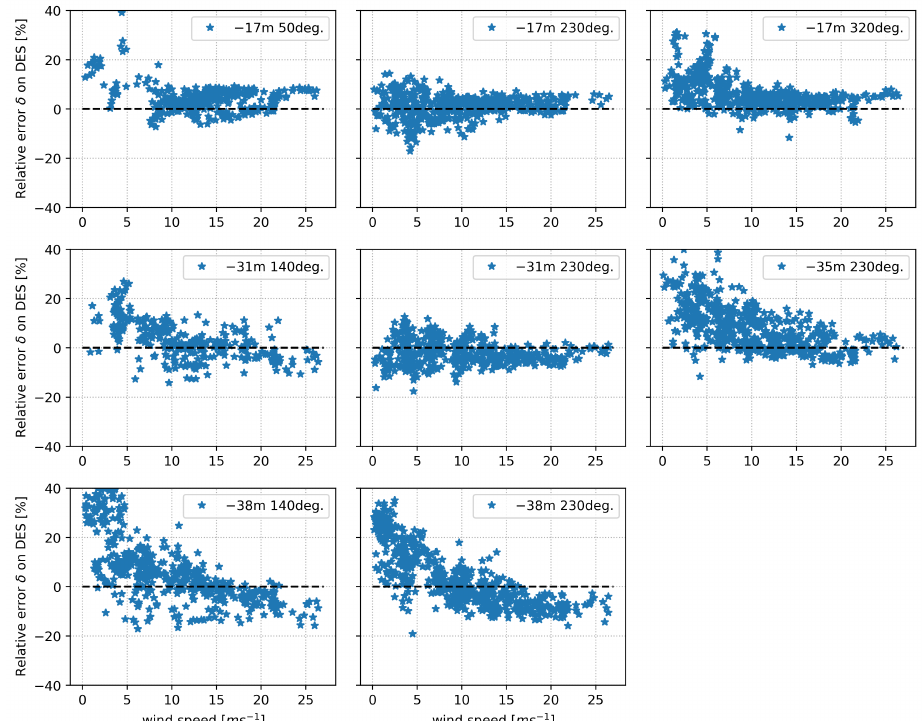
Figure A4. Relative error δ on DES for sensors on the